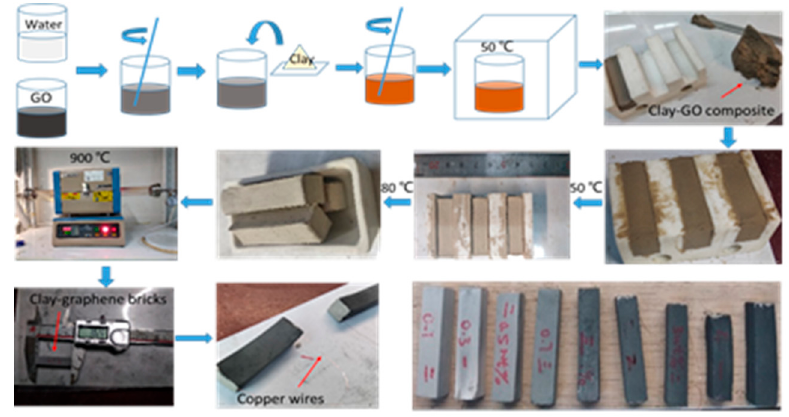
Figure 1. The preparation process of the graphene bricks.